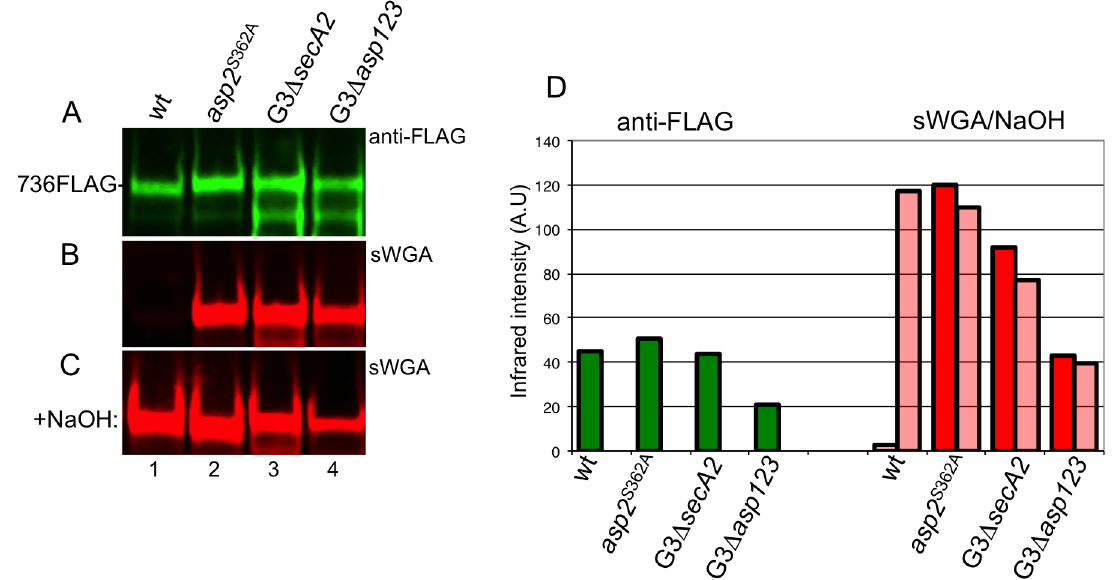
Fig 7. Assessment of anti-FLAG and sWGA reactivity of GspB736flag when exportedthrough the general secretory pathway. A) Western blot analysisof GlcNAc-modifiedGspB736flag exported throughthe aSec system from the Δ gly-nss parentalstrainPS3309(lane1) andderivativestrainharboringthe Asp2 S362Amutation,PS3540(lane2), or whenreroutedto the Sec pathway (via the * G3signalsequencemutation[26])by the Δ gly-nss accessorySec deficientstrainsPS3316(lane3), PS3317(lane4). B) sWGA reactivityof GspB736flag exportedviathe aSec or Sec system in definedglycosylation backgrounds. C) GlcNAc reactivityof secretedGspB736flag followingsaponification. GlcNAc reactivitywas assessed throughlectinblot analysisusingbiotinylated sWGA as a GlcNAc probe.D) Densitometry analysisof GspB736flag levels(greenbars)andGlcNAc reactivitybefore(redbars) andafter saponification treatment(openred bars). The y-axis representsGspB736flag levelsand GlcNAc reactivitybasedon bandintensityanalysisvia LI-CORimaging.Western andlectinblot analysisof secretedGspB variantstogetherwith correspondingdensitometry analysisare representative of at least three differentgenetictransformants of eachstrain